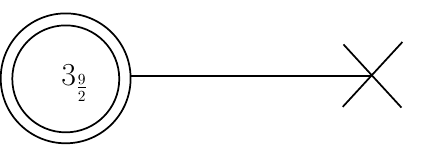
Figure 4 . The theory T x with SU(3) = Z 3 gauged at level k = 9 = 2. The theory is dual to a chiral (cid:12)eld with cubic superpotential. The double circle denotes the SU(3) = Z 3 gauging. The di(cid:11)erent level here and in the previous (cid:12)gure is because the duality involves a relative contact